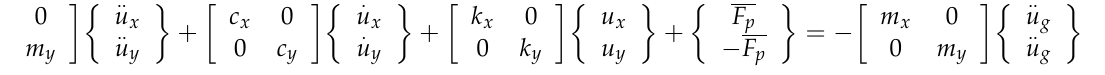
Figure 6. Moment-rotation backbone curve and hysteresis loop simulated by the OpenSees hysteretic model.